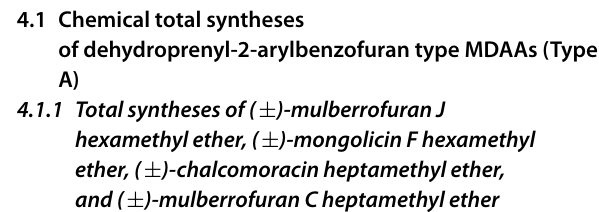
a 1-DNJ 1-Deoxynojirimycin, LUT Lutenolin